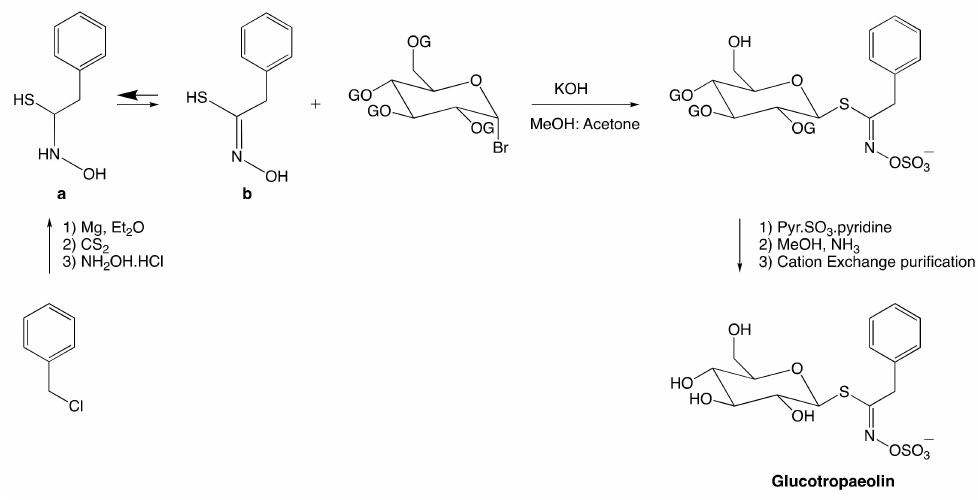
Figure 5. Synthesis of glucotropaeolin. OG represents a suitable protecting